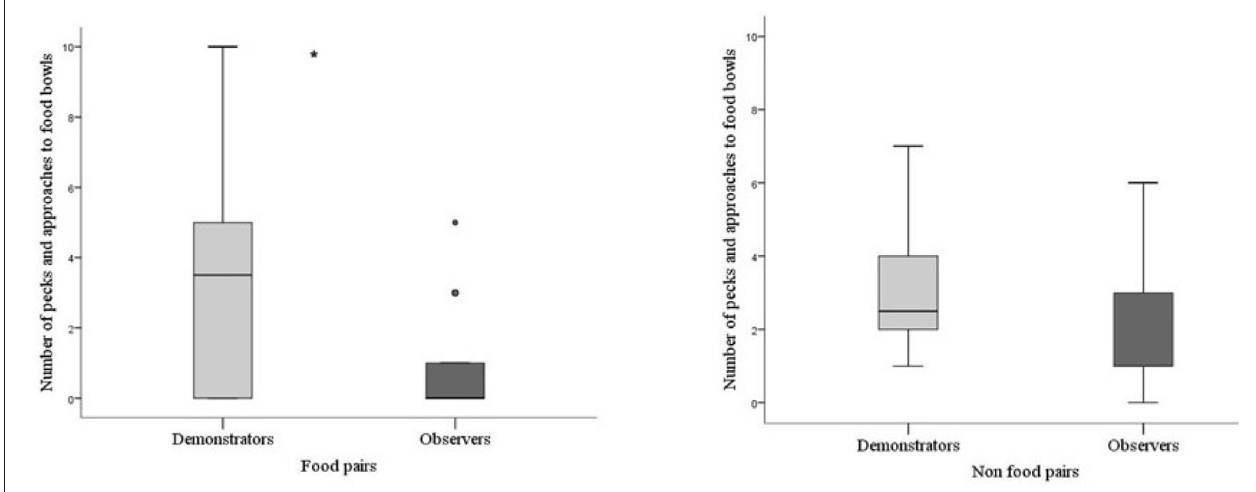
FIGURE 4 | Pecks and approaches toward food bowls by demonstrators and observers in food and non-food pairs in batch 2. Thick horizontal lines indicates median nr of pecks, boxes span from the first to the third quartiles and the whiskers represent 95% confidence interval; outliers are denoted by dots. Demonstrators ( N = 14) are the light gray bar and observers ( N = 14) dark gray bar. The asterisk indicates a significant difference between